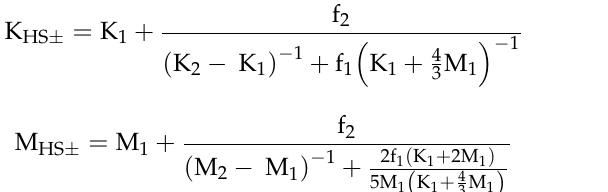
Table 2. The expected elastic moduli and density of minerals for RPT [59]. Minerals Bulk Modulus (GPa) Quartz